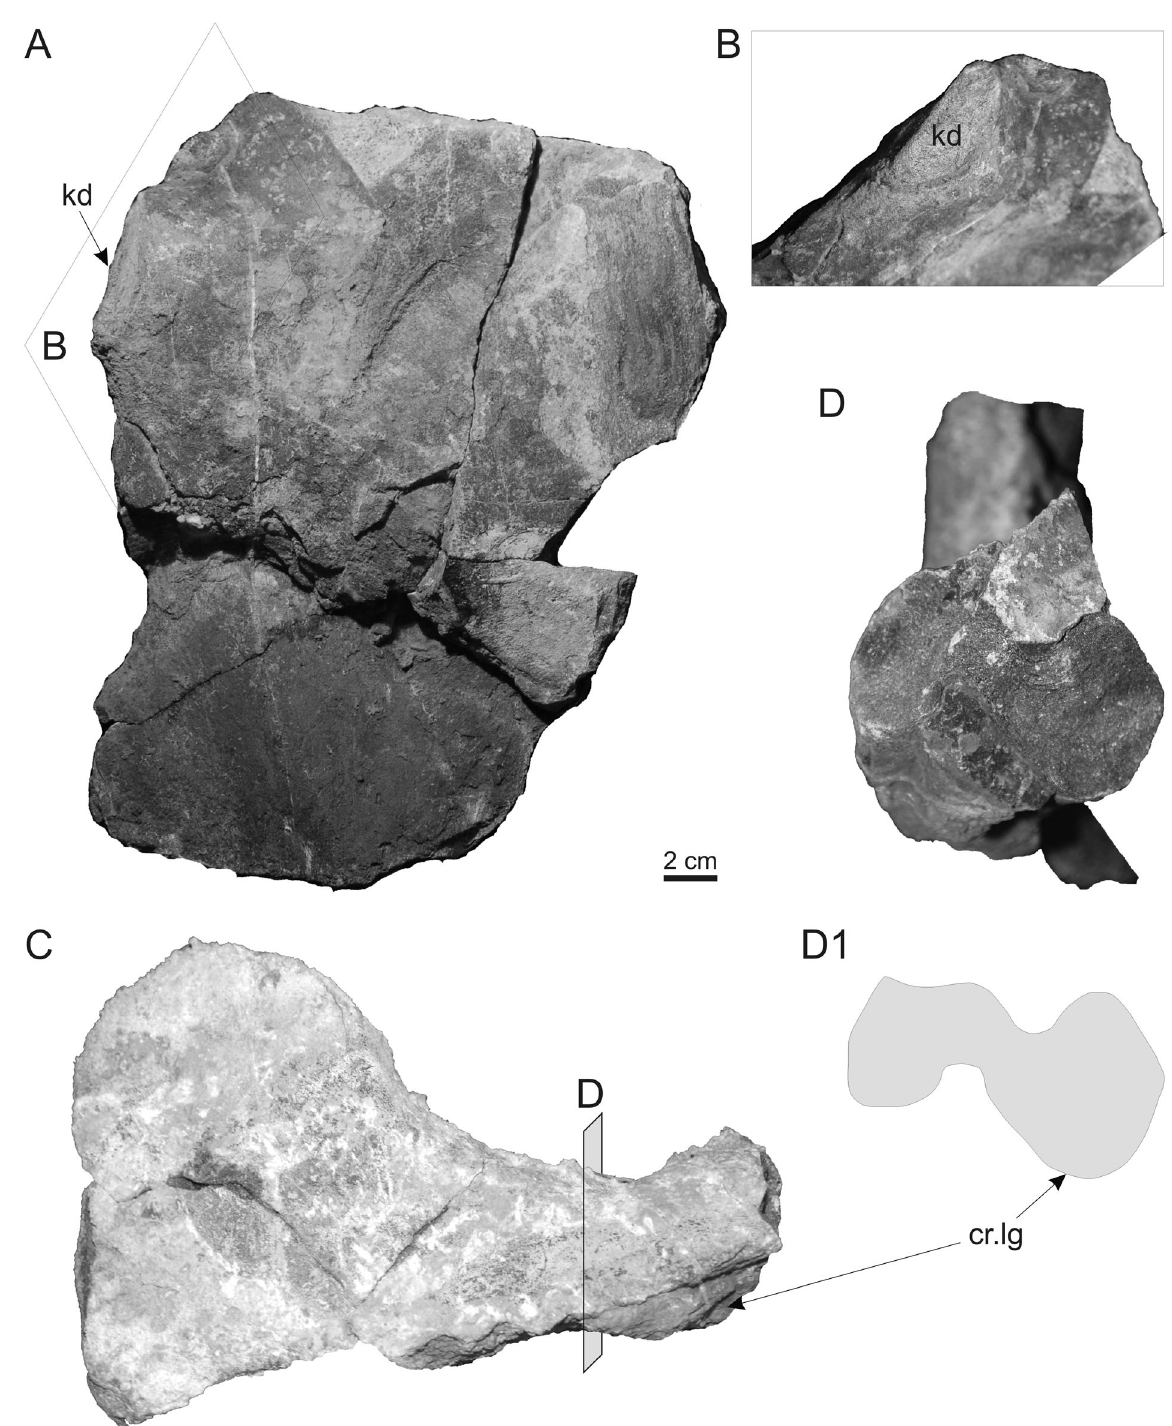
Fig. 3. A , specimen Muz. PGI-NRI 1809.II.20 right anterior dorsolateral plate (ADL) in visceral view. B , magnified area marked on A with a broken glenoid condyle (kd) area. C , specimen Muz. PGI-NRI 1809.II.22, right suborbital plate in external view. D , cross section of the part of the lower part of the suborbital plate (marked on C). D1 , outline of the cross section illustrated on D with the linguiform process (cr.lg)